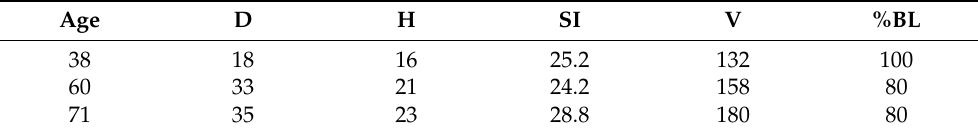
Table 1. Age (years), mean diameter (D, cm), height (H, m), site index (SI, m), growing stock (V, m 3 · ha − 1 ) and black locust fraction (%BL [%]) for the investigated black locust stands. Age D